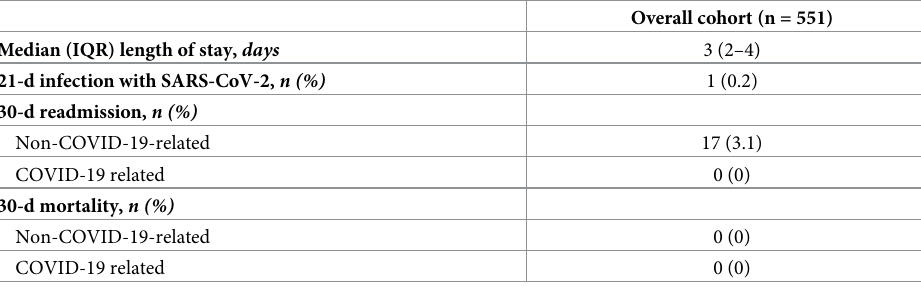
Table 3. Postoperative